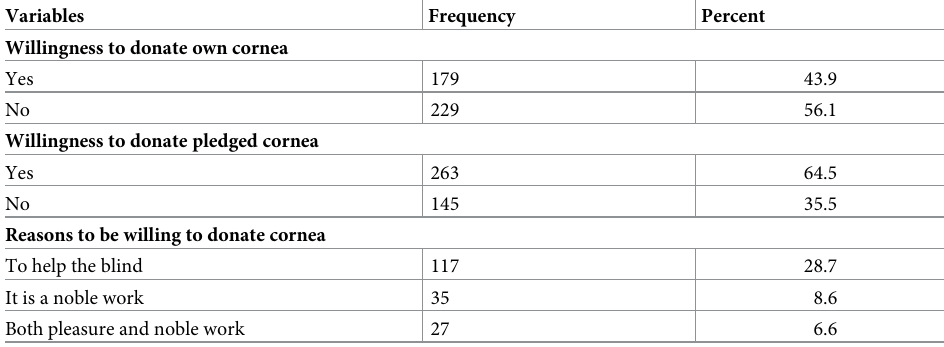
Table 3. Willingness to donate cornea and perceived reasons among patients attending University of Gondar Comprehensive and Specialized Hospital, July 2020.